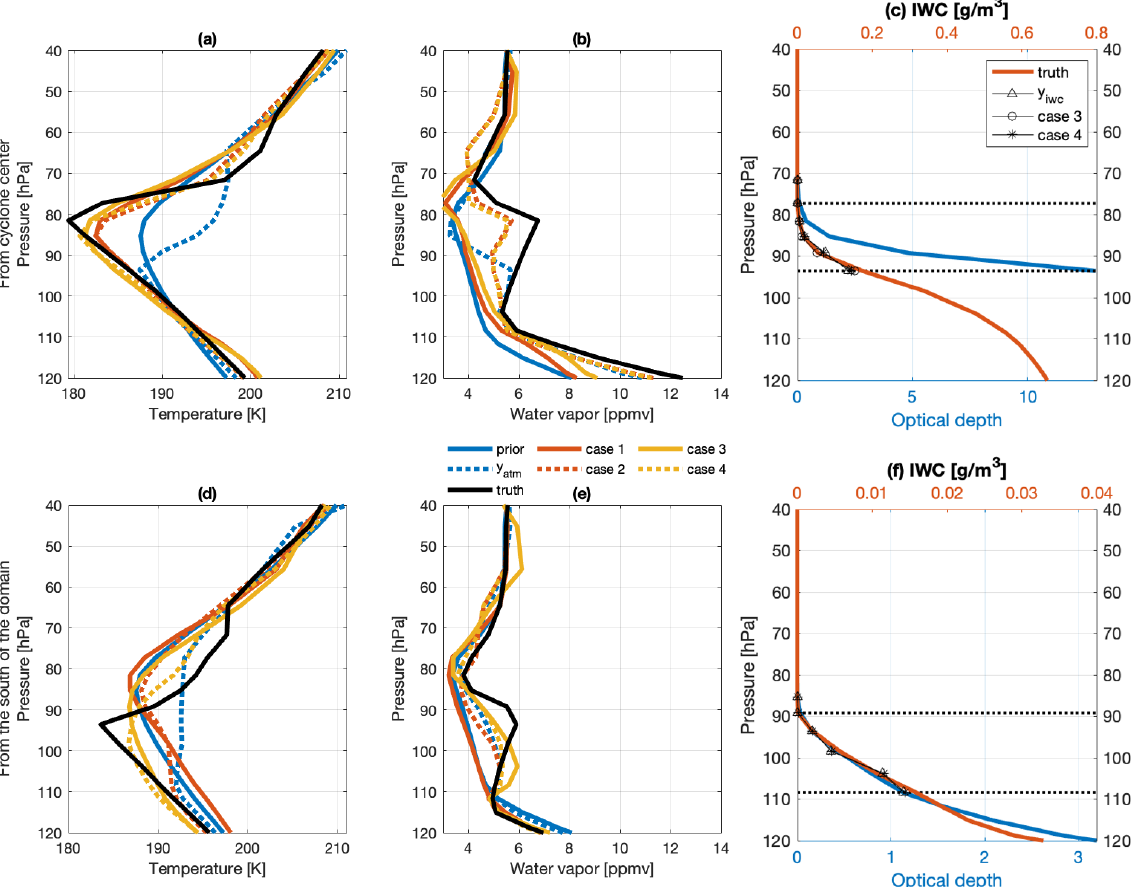
Figure 7. Temperature (a, d) and water vapor (b, e) profiles of the first guess (solid blue lines), truth (solid black lines), and posterior results (red and yellow lines represent the slab-cloud and synergistic methods, respectively; the solid lines refer to cases without y atm and the dotted lines to cases that include y atm ) for two profiles from the test set. (c, f) True IWC (red curve and upper x axis) and all-sky optical depth from the TOA (blue curve and lower x axis) for the two selected profiles. The y iwc and retrieved IWC profile are indicated by triangles, circles (Case 3), and asterisks (Case 4), respectively. Dotted black lines mark the vertical ranges of ice cloud information included in y iwc and x iwc , while ice clouds at the lower vertical levels are prescribed to be the same as the observed